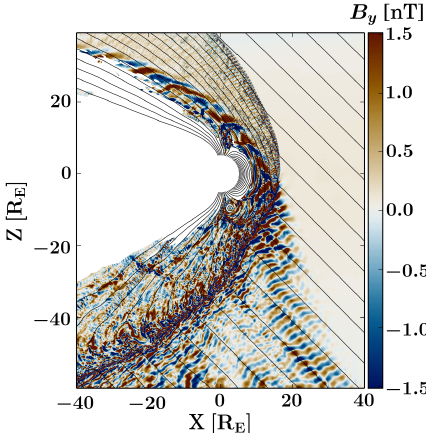
Figure 1. Zoomed-in image of the magnetosheath and foreshock region of the Vlasiator simulation used in this analysis. The figure shows the region of solar wind interaction with the magnetosphere, with the colour scale indicating the out-of-plane magnetic field component B y , showing fluctuations both in the magnetosheath and in the foreshock. Black lines indicate magnetic field lines in the x – z plane. The inner boundary is placed at 5 R E , and the tail region is excluded from the plot for